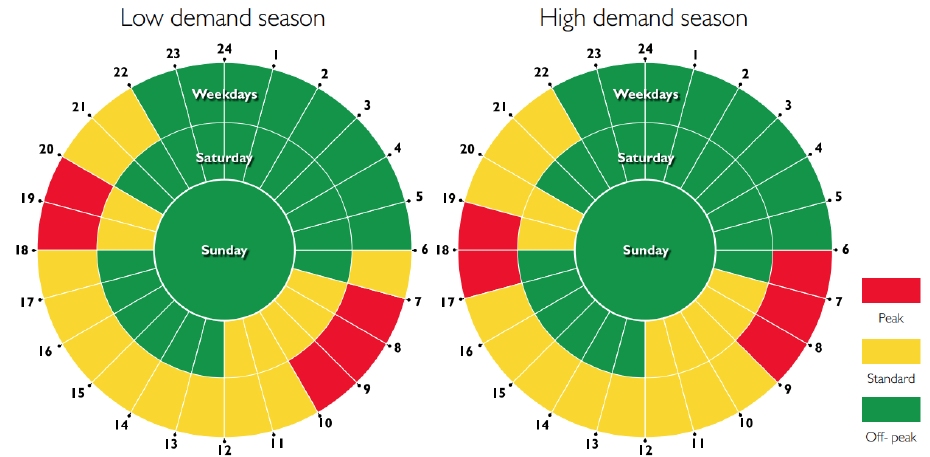
Figure 5. Low- and high-demand seasons’ TOU periods Figure 5. Low and high demand seasons TOU periods [39].